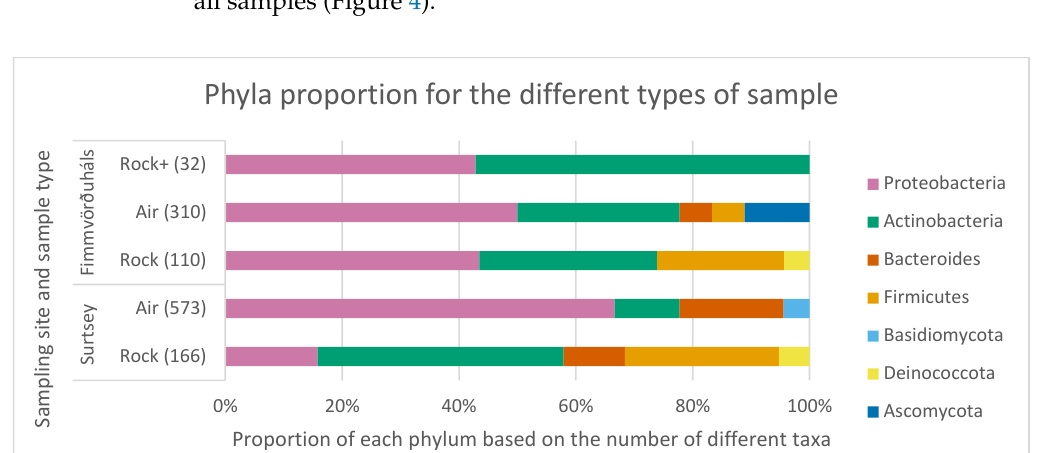
Figure 4. Stacked bar plot showing the proportion of the different phyla in each sampling site and type. The numbers under brackets represent the number of isolates. The eukaryotes phyla appear in blue. Rock represents the one-year-old lava rocks whereas Rock+ represents the nine-year-old lava rocks. Adapted for colour blindness.Cultivable representatives of the phylum Bacteroides were found in all samples except the one-year-old lava rocks of Fimmvörðuh á ls, and Firmicutes in all samples except the air of Surtsey. Members of Deinococcota were found in the one-year-old lava rock samples at both sites but not in the air and the nine-year-old lava rock of Fimmvörðuh á ls. Eukaryotic phyla were only found in the air with a member of Ascomycota cultivated from the air of Fimmvörðuh á ls and a member of Basidiomycota cultivated from the air of